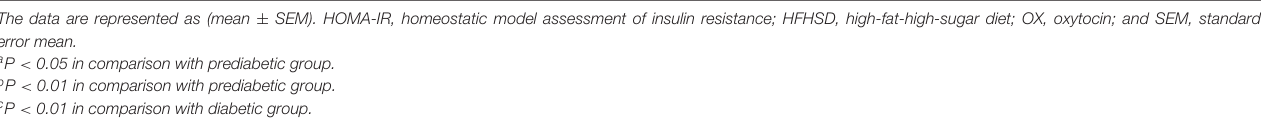
prediabetic and diabetic rats after oxytocin administration [